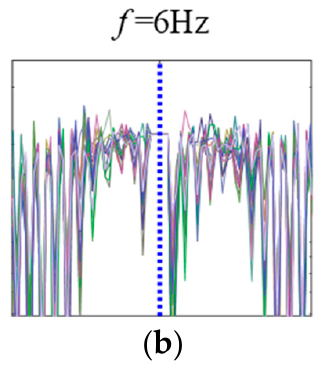
ij t of response in a finite time period (19 groups). Figure 8. Delayed TRF Figure 8. Delayed TRF t ij of response in a finite time period (19 groups). 34 34